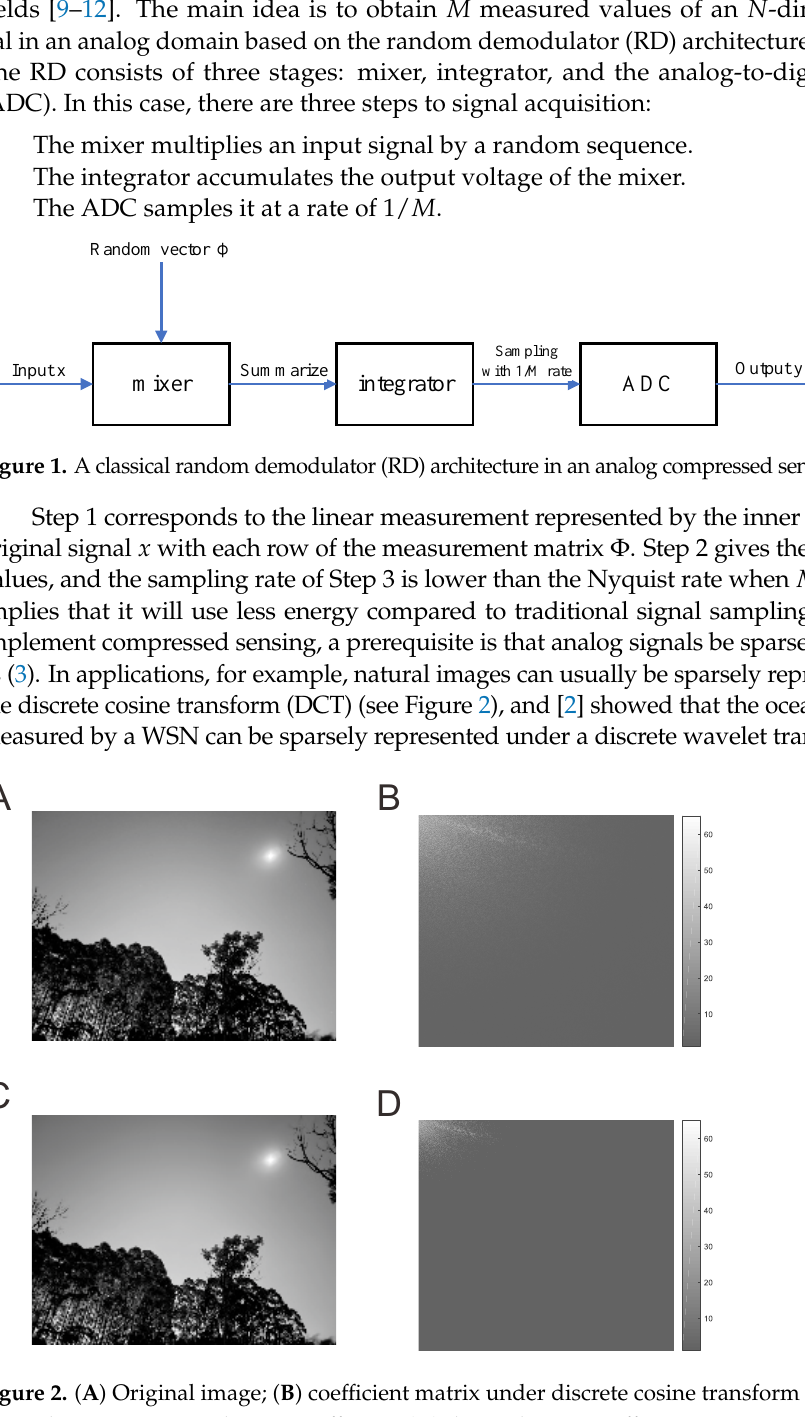
Figure 2. ( A ) Original image; ( B ) coefficient matrix under discrete cosine transform (DCT); ( C ) com- pressed image using 5% largest coefficient; ( D ) the 5% largest coefficient